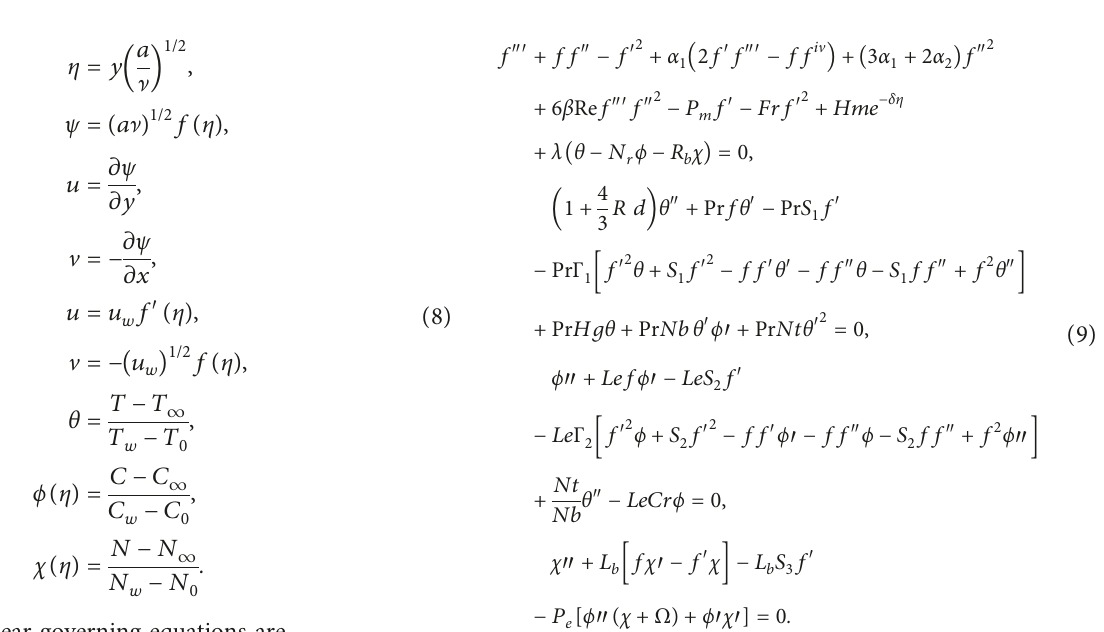
, α ,Ha, P , Pe, Nr,Rb, and S m 1 2